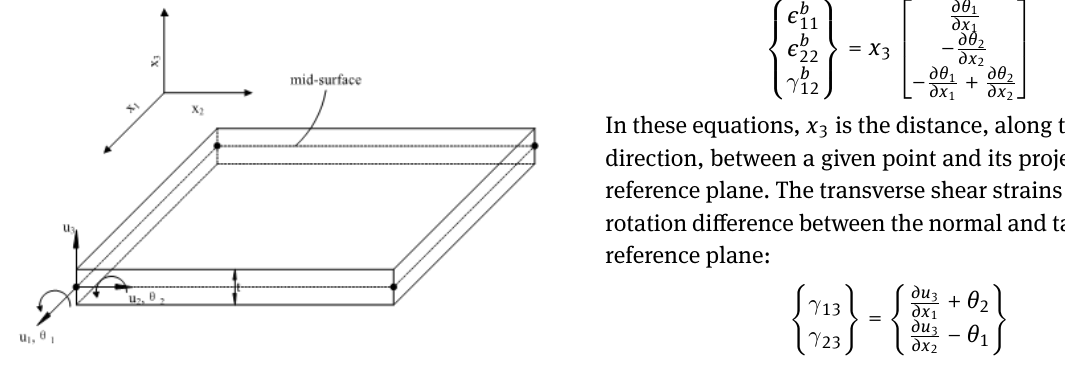
Figure 1: A flat shell element with in-plane and bending deformation